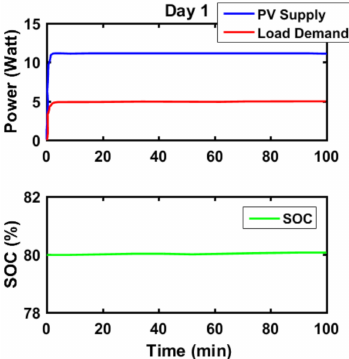
Figure 8. Experimental analysis for Day 1: 620 W / m 2 , 29 ◦ C.